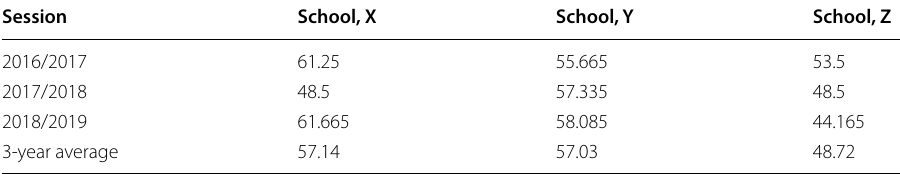
Table 4 Sessional average in Mathematics in Junior Secondary School 1